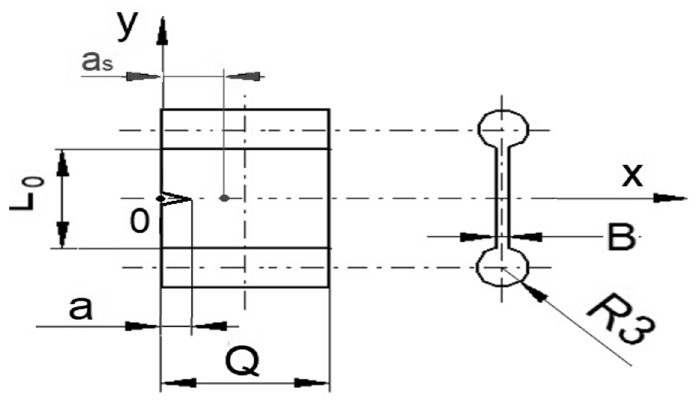
Figure 1. Geometry of single edge notched tensile (SENT)